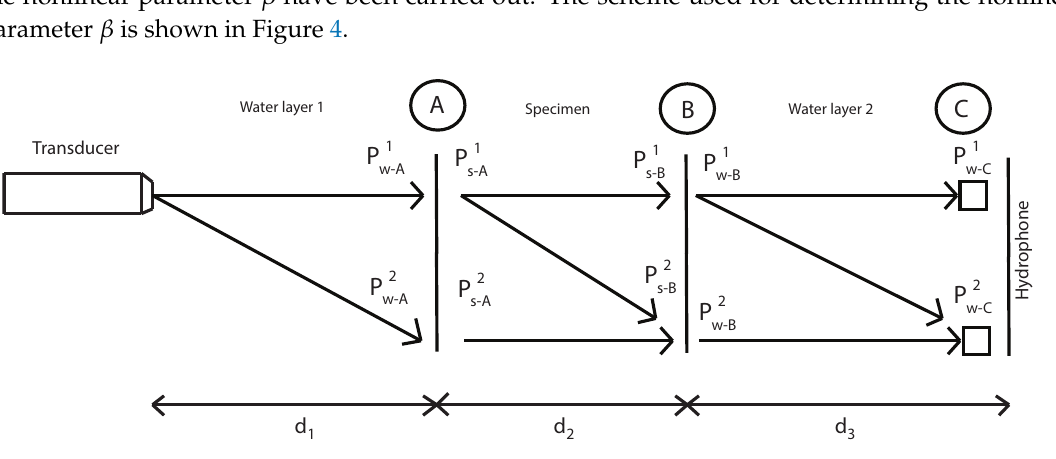
Figure 4. Semi-analytical approach used to extract the nonlinear material’s properties from the